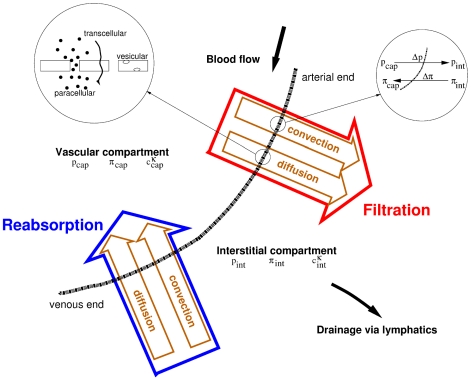
Processes and forces of transvascular exchange [48].